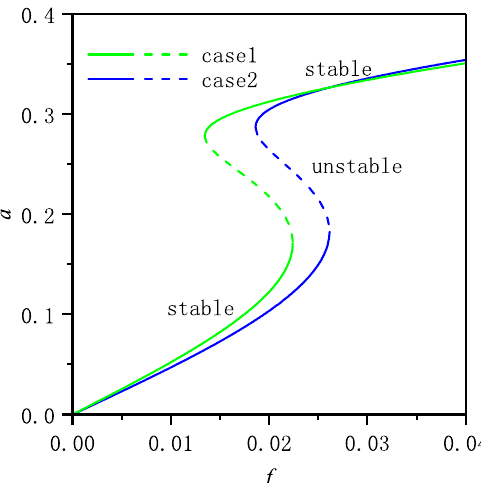
Figure 17. Comparison of response amplitude between the time delayed velocity feedback and the time delayed acceleration feedback.